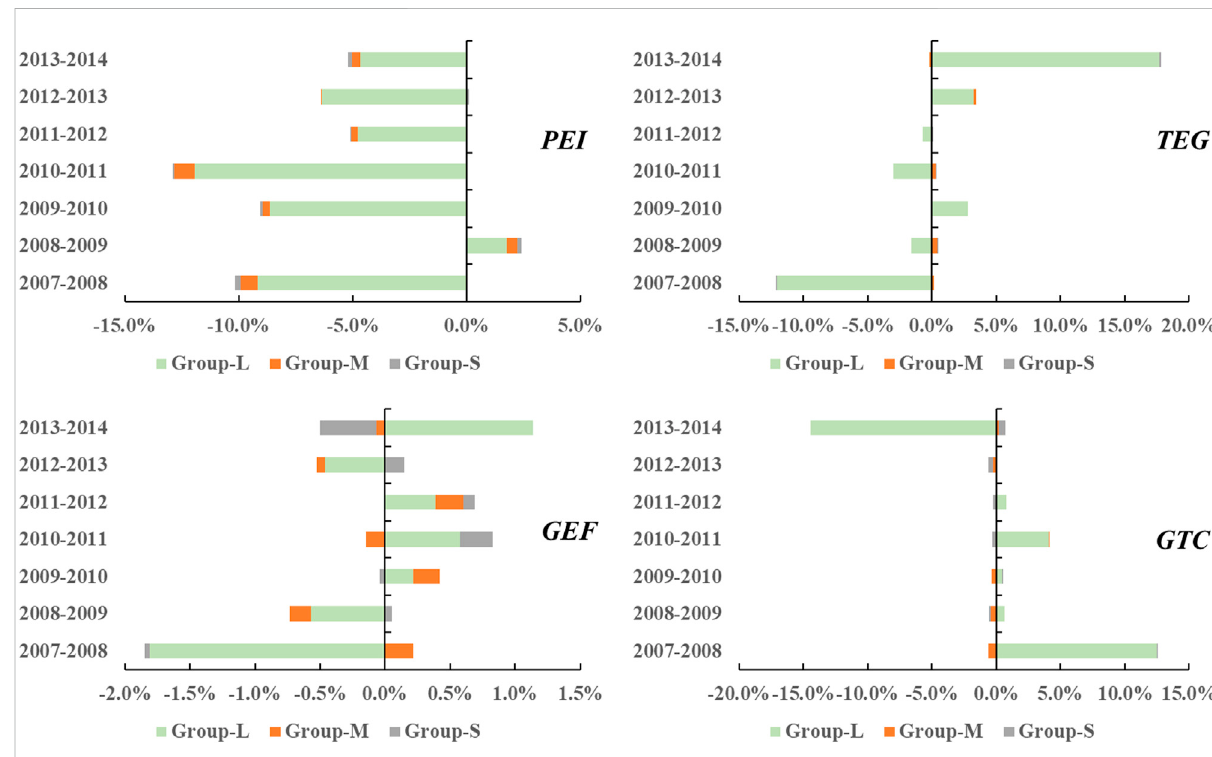
FIGURE 6 Percentage of the single-stage attribution results of the production process ( PEI, TEG, GEF , and GTC ) of each grouped country from 2007 to 2014 (Unit: